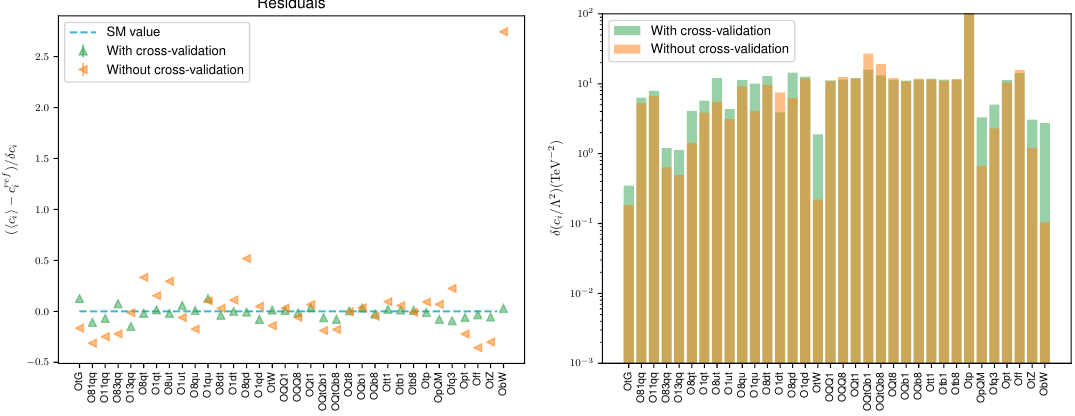
Figure 10 . Same as (cid:12)gure 6 comparing the L2 closure tests with and without cross-validation.